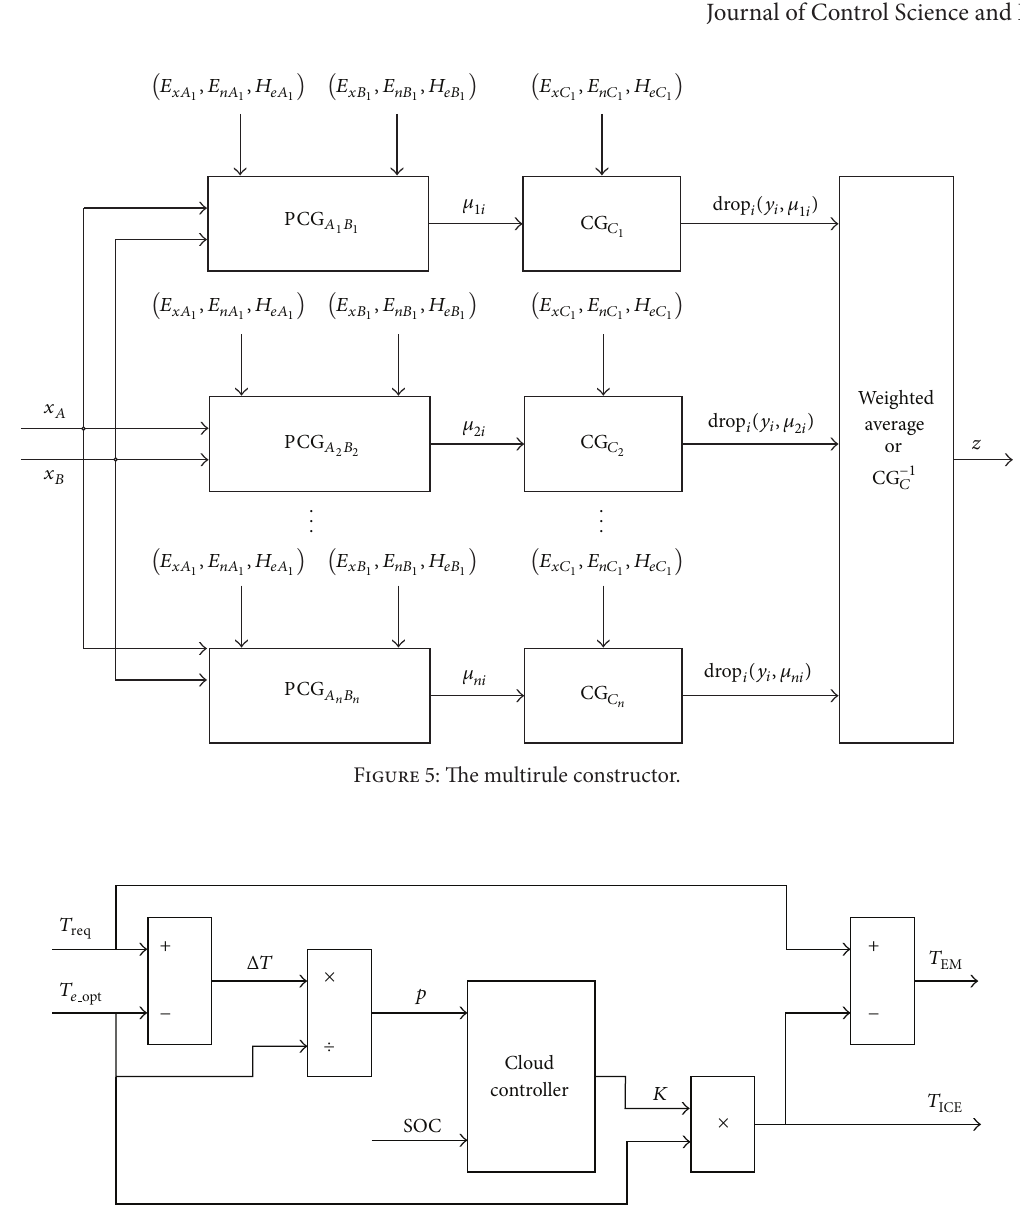
Figure 6: Simplified block diagram of the power